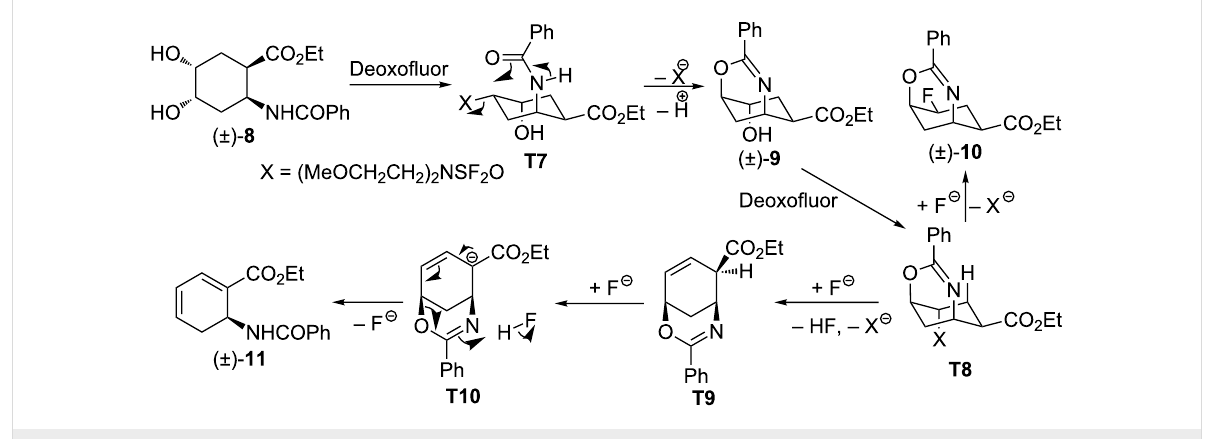
Scheme 5: Proposed route for the formation of compounds (±)- 10 and (±)- 11 .